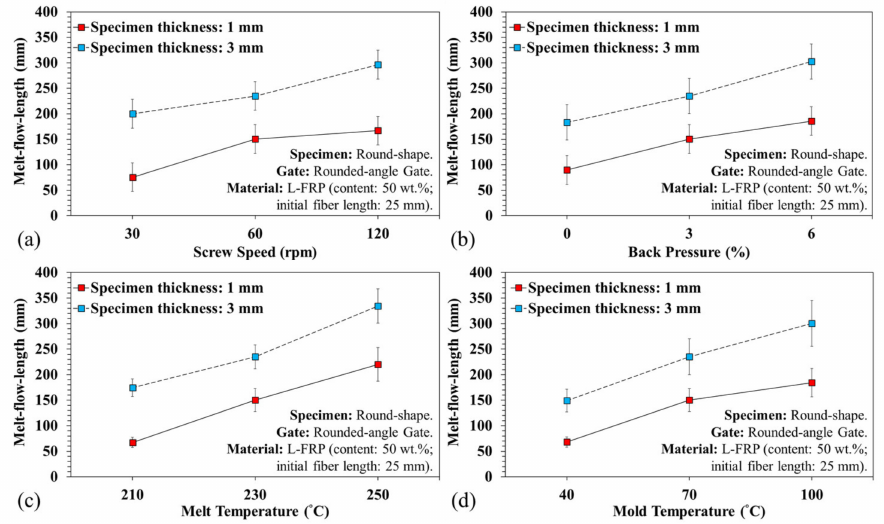
Figure 8. Variations of melt flow length under different specimen thicknesses and plasticization parameters: ( a ) variations of screw speed, ( b ) variations of back pressure, ( c ) variations of melt temperature, and ( d ) variations of mold